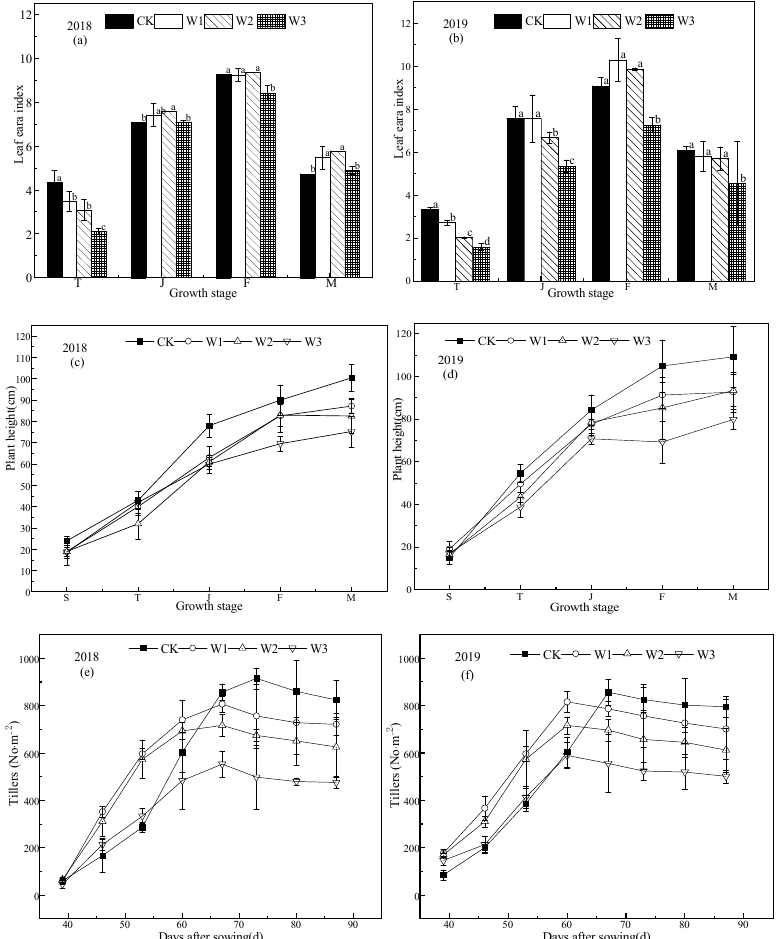
Figure 5. Effect of different water conditions on rice growth. The ( a ), ( c ), ( e ) represent the leaf area index (LAI), plant height, and number of tillers per unit area respectively in 2018. ( b ), ( d ), ( f ) represent the the leaf area index, plant height, and number of tillers per unit area respectively in 2019. T, J, F, and M represent the tillering, jointing, grouting, and mature stages, respectively. CK: flooding treatment, W1: Irrigation limit 0.85–1.00 θ s, W2: Irrigation limit 0.75–1.00 θ s, and W3: Irrigation limit 0.65–1.00 θ s. The data are the mean ± the standard error. Different letters indicate significant differences between treatments ( p < 0.05).